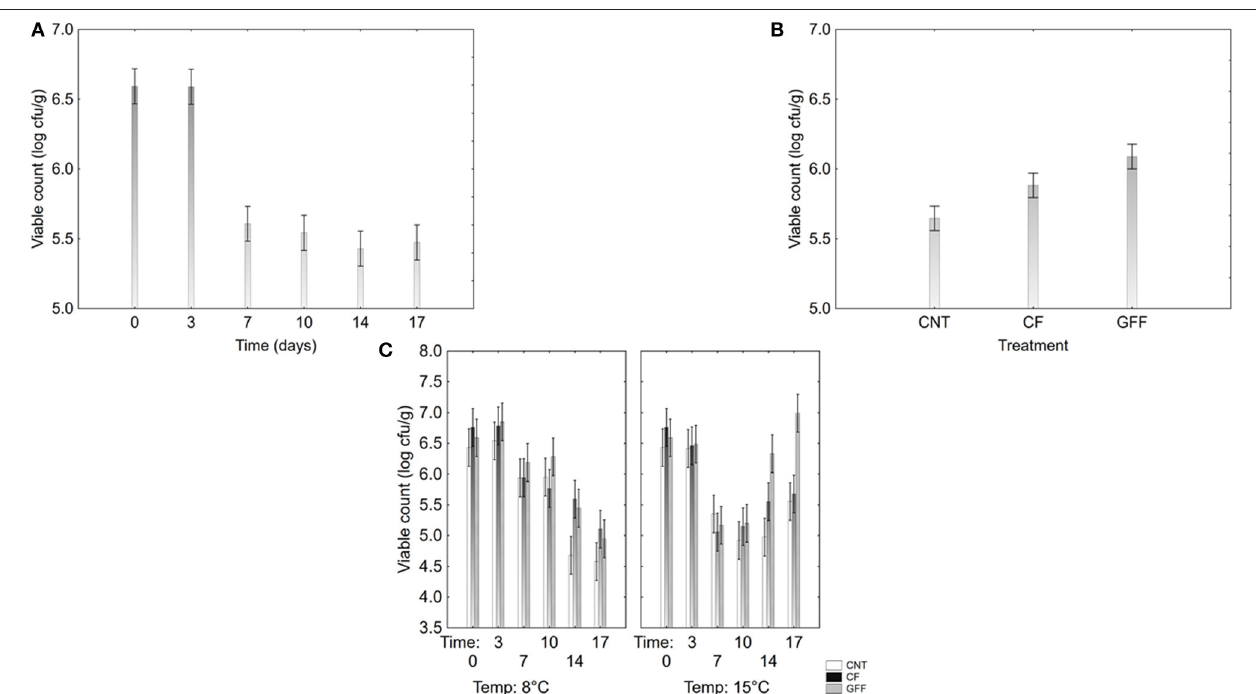
FIGURE 8 | Decomposition of the statistical hypothesis of multifactorial ANOVA on the viable count of B. infantis . In the yogurt. (A) , effect of the storage time; (B) , effect of flour addition; (C) , interaction time*temperature*flour addition. CNT, without flour (control); CF, Control Flour; GF, Gluten Friendly Flour. The bars represent the 95%-confidence